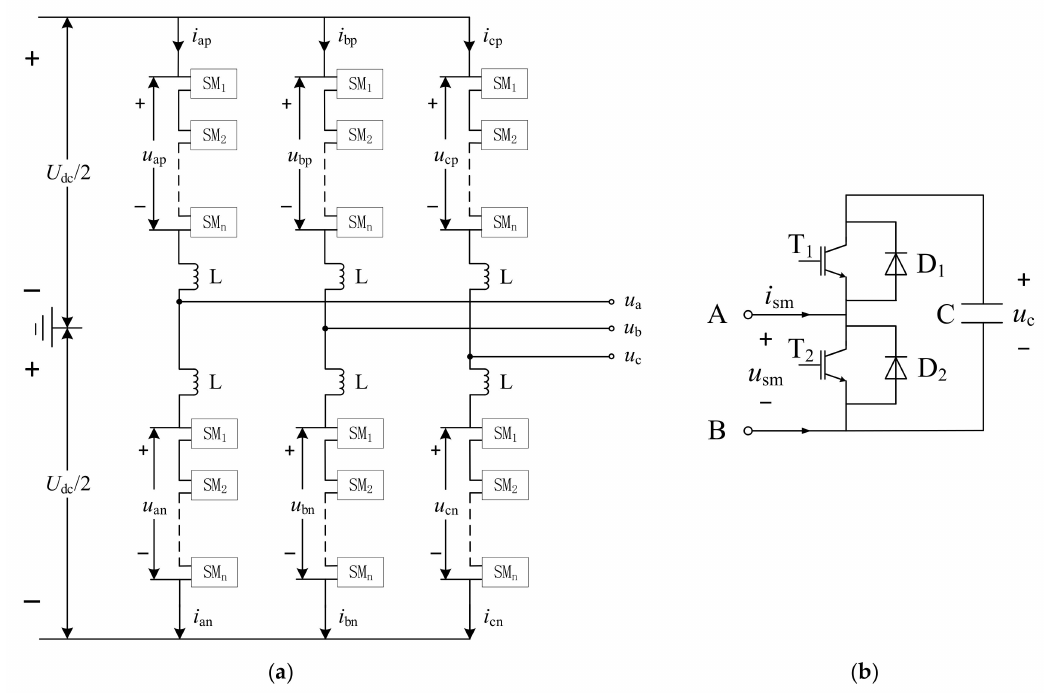
Figure 1. Topology of three-phase MMC and submodule: ( a ) topology of three-phase MMC; ( b ) topology of submodule. Each SM of the MMC has two IGBTs, which are always in a complementary state at any time during normal operation. The working state of the SMs is shown in Table